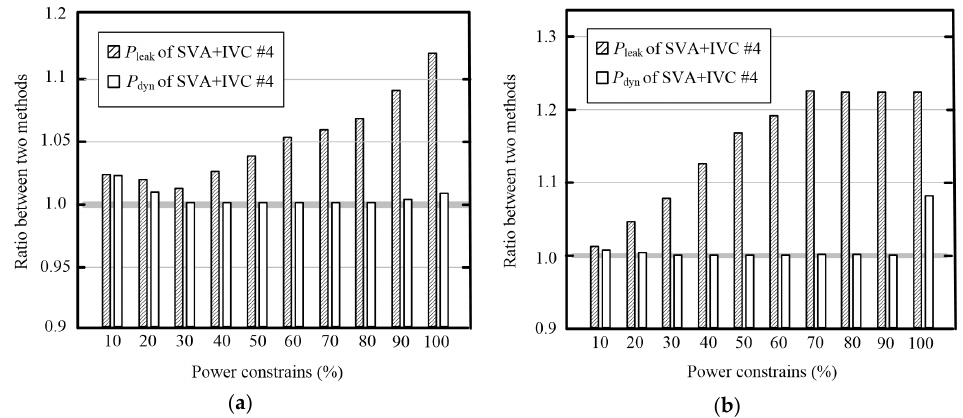
Figure 8. Leakage and dynamic power of SVA for the c880 and c3540 circuits when using the input vector obtained by the co-optimization method in Ref. [27] under different power constrain settings. ( a ) c880 circuit; ( b ) c3540 circuit.